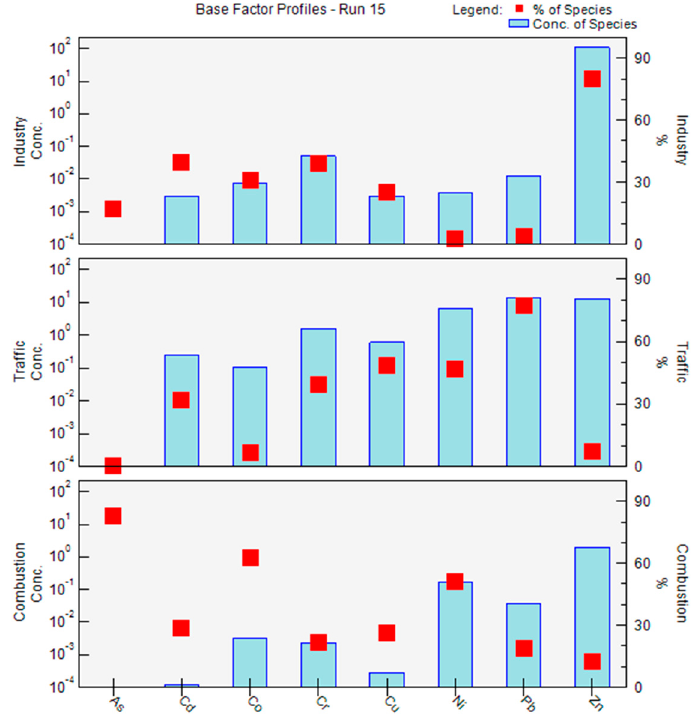
Figure 2. Source profiles obtained by the PMF analyses for Yuci College Town, Shanxi, China. Bars represent mass concentrations and red squares represent contribution percentages from each source factor.